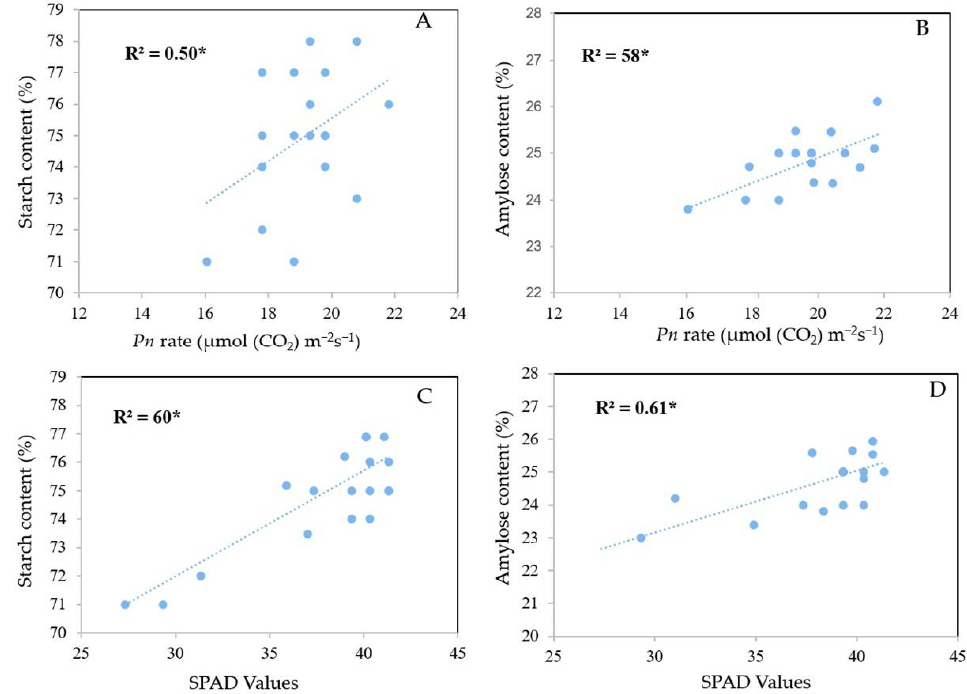
Figure 7. Linear regression analysis of starch content ( A , B ) and amylose content ( C , D ) with the net photosynthetic rate and the SPAD values. * = significant at 1%. n = 18.